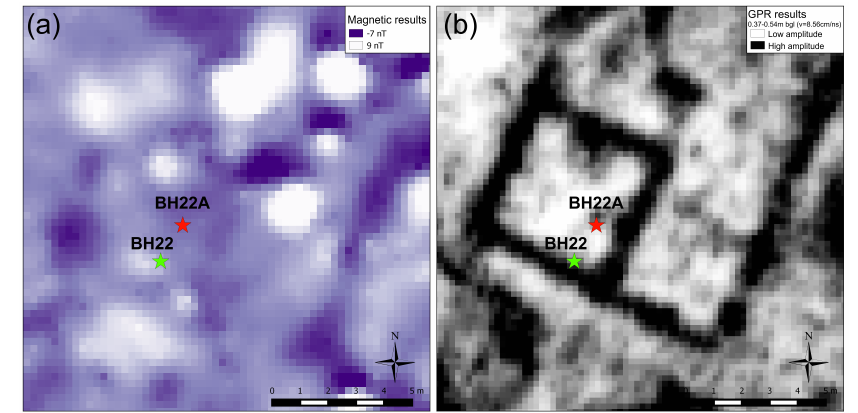
Figure 15. ( a ) Cores BH22 (Obstruction) and BH22A (negative) over the magnetic results; ( b ) GPR results where showing that the core BH22 encountered a wall whereas the BH22A was located within a building. The area is highlighted in the general context of Figure 6.